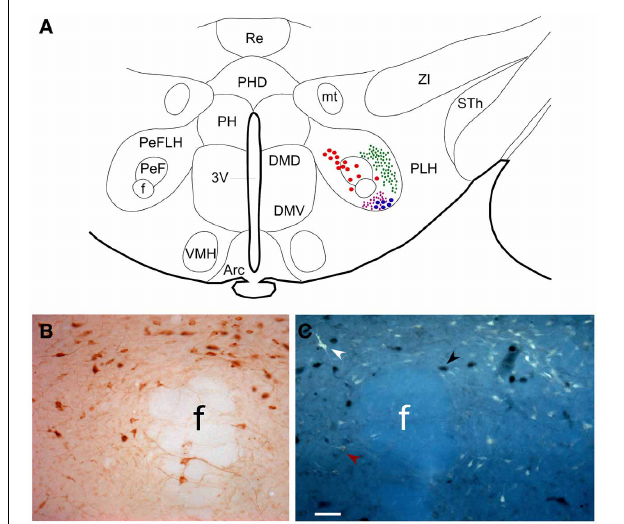
FIGURE 2 | (A) Schematic drawing of the hypothalamic area in a coronal section of rat brain at antero-posterior coordinates Bregma − 3.36mm. It is shown the distribution of neurons projecting to PnO (red dots) and LC (blue dots) and the distribution of fiber terminals arising PnO and LC are represented in green and purple small dots, respectively. (B) Microphotograph of PeF showing neurons immunocytochemically stained for anti-Orx. (C) Microphotograph showing adjacent section showed in (B) where Orx neurons are pointed by black arrowheads, FG neurons projecting to LC by white arrowheads and double labeled neurons by red arrowheads. Calibration bar: 50 μ m. Abbreviations: 3V: 3rd ventricle; Arc: arcuate hypothalamic nucleus; DMD: dorsomedial hypothalamic nucleus, dorsal part; DMV: dorsomedial hypothalamic nucleus, ventral part; f: